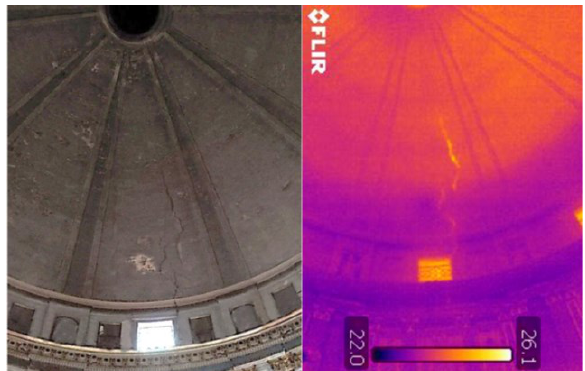
Figure 8. The crack on a dome slice and the corresponding thermal image